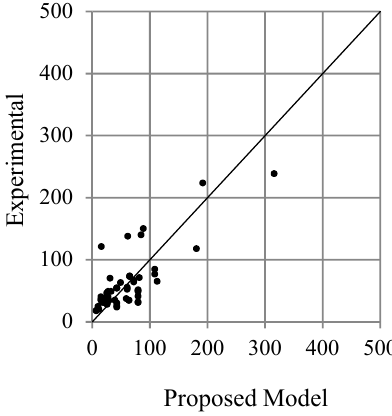
Figure 18. Comparison of the debonding load between the proposed model ( ω = 6) and the experimental results.